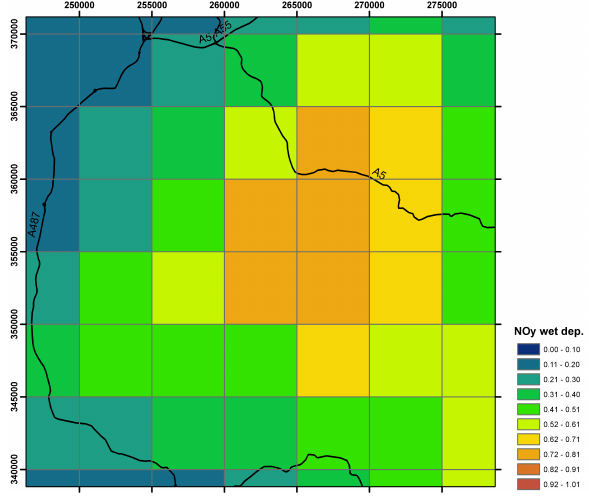
Fig. 4b. NO y wet deposition in Snowdonia (keqha − 1 ) with 5km grid